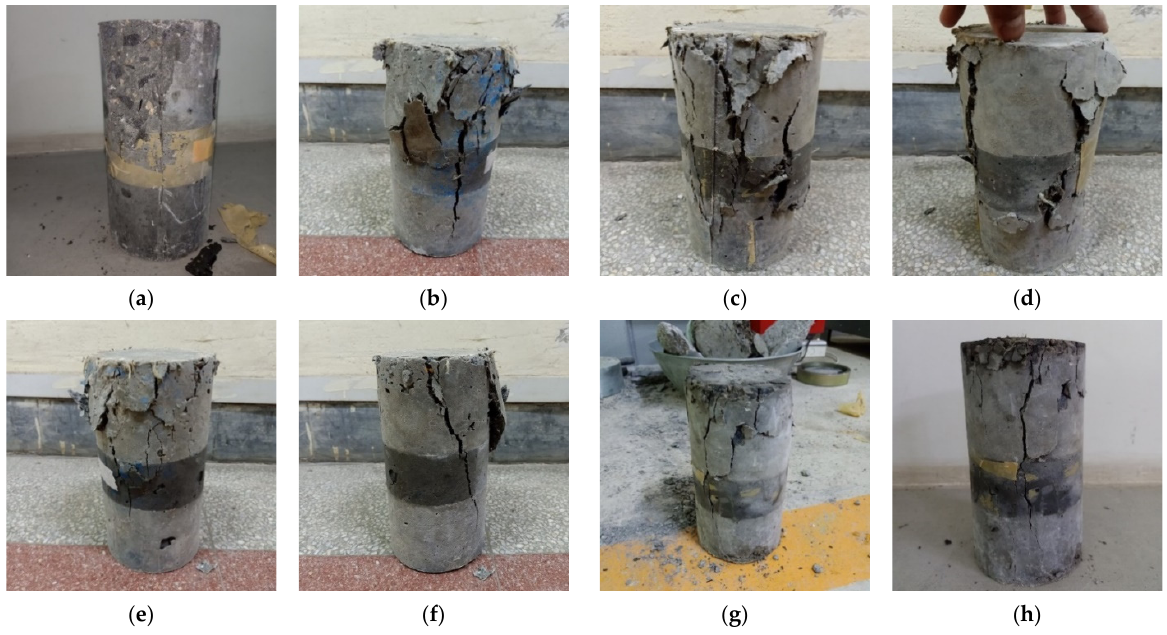
Figure 4. Compressive failure modes of specimens: ( a ) CM; ( b ) M-G 1.5 ; ( c ) HF-G 1.25 K 0.25 ; ( d ) HF-G 1 K 0.5 ; ( e ) HF-G 0.75 K 0.75 ; ( f ) HF-G 0.5 K 1 ; ( g ) HF-G 0.25 K 1.25 ; ( h ) M-K 1.5 .